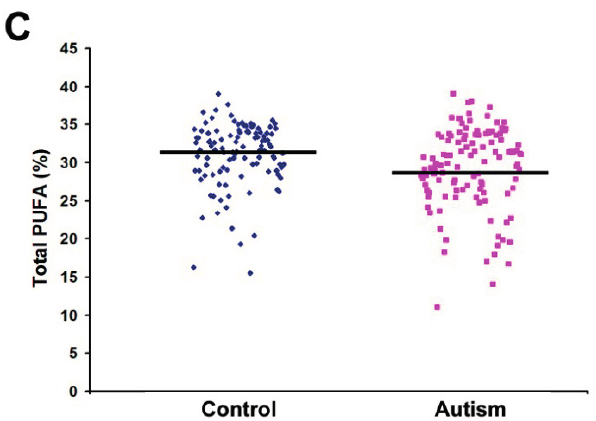
Figure 2. Scatterplot showing the distribution of fatty acid percentages of AA ( A ); docosahexaenoic acid (DHA) ( B ); and total PUFA ( C ) between control and autism groups. Phospholipids were extracted from red blood cell (RBC) samples of control subjects ( n = 110) and autism patients ( n = 121) and analyzed by gas chromatography. Bars represent the mean values (refer to Table 1 for significance).